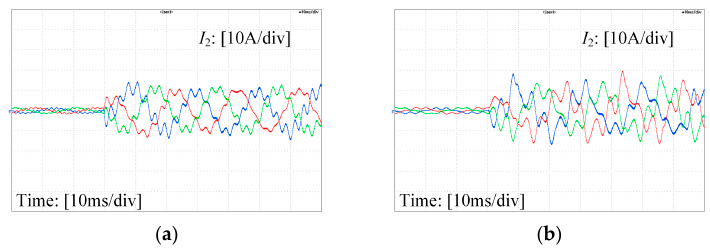
Figure 16. Grid-connected converter starting in rectifier mode with SCVDFF. ( a ) SCR = 10; ( b ) SCR = 2.